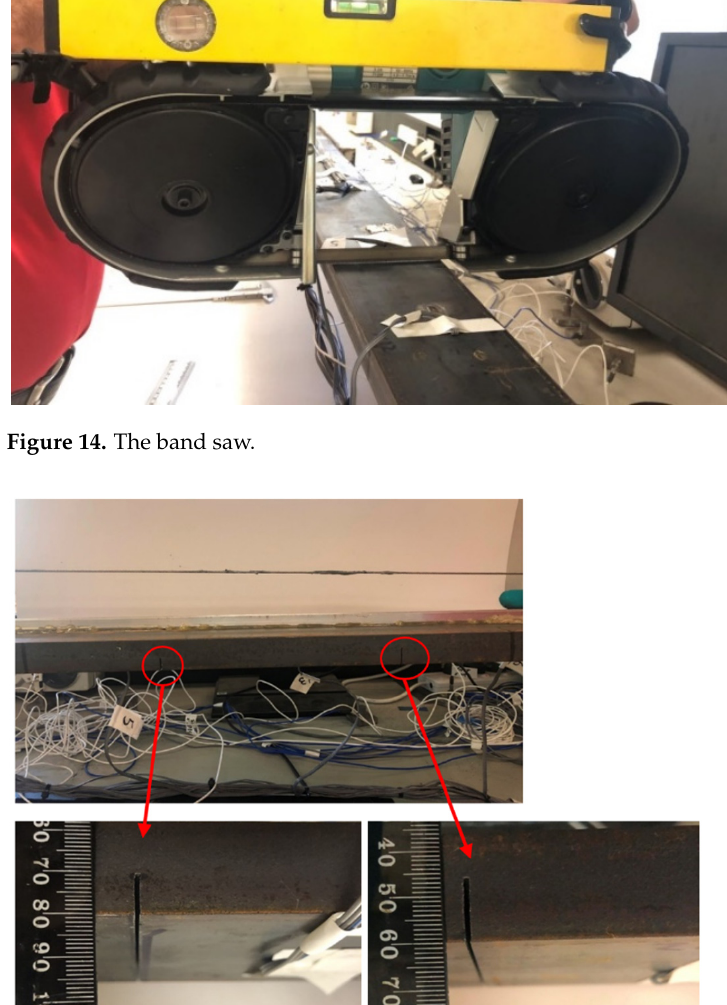
Figure 15. The induced damage on the bottom of the beam.